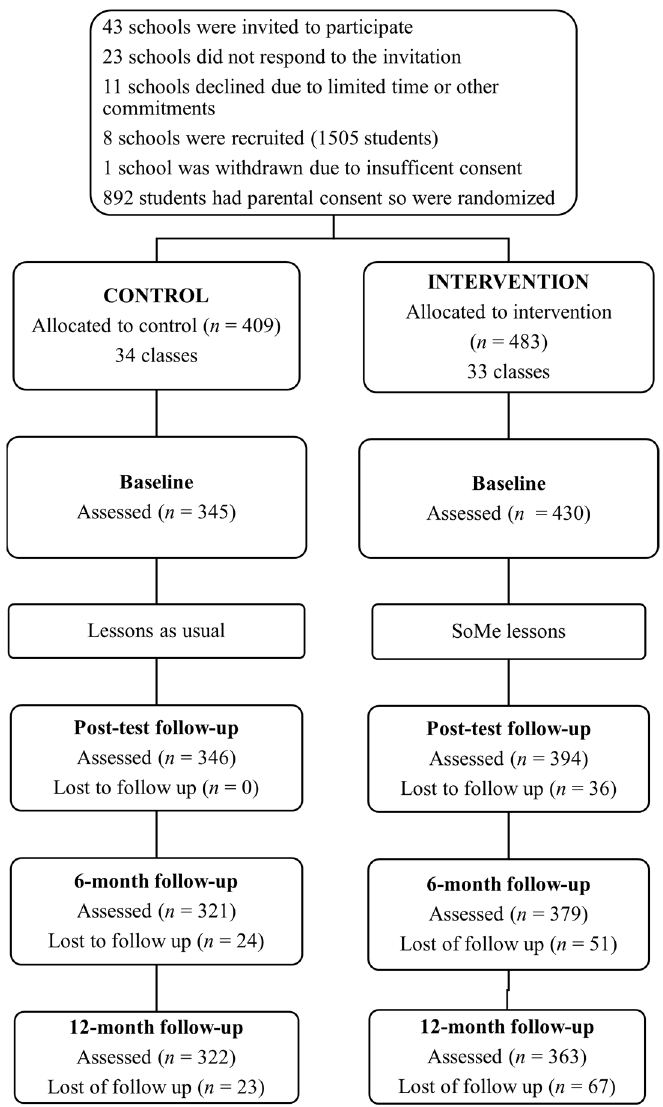
Figure 1. Summary of participant flow.